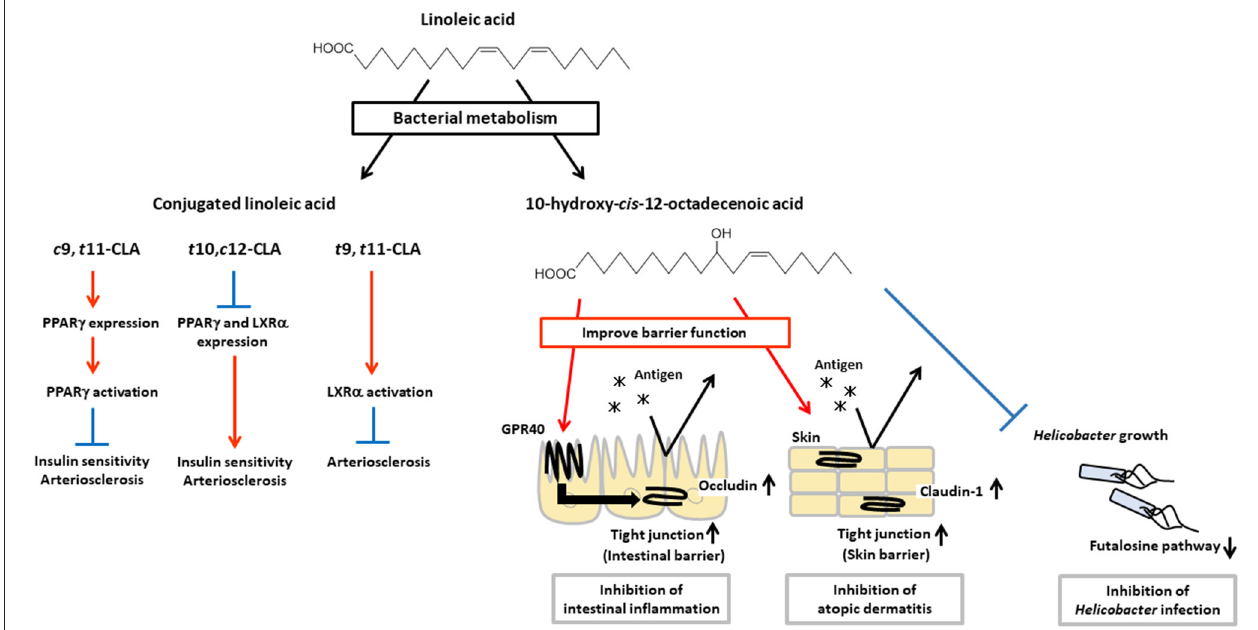
FIGURE 3 | Physiological functions of CLA and HYA. CLA and HYA are produced from linoleic acid by intestinal bacteria. c 9, t 11-CLA ameliorates insulin sensitivity and prevents atherosclerosis, t 10, c 12-CLA deteriorates insulin sensitivity and promotes atherosclerosis, and t 9, t 11-CLA prevents atherosclerosis. HYA enhances intestinal barrier function by increasing occludin expression and inhibiting intestinal inflammation in a GPR40-dependent manner. HYA inhibits atopic dermatitis by increasing claudin-1 expression and enhancing skin barrier function. HYA also inhibits gastric Helicobacter infections by blocking the bacterial futalosine